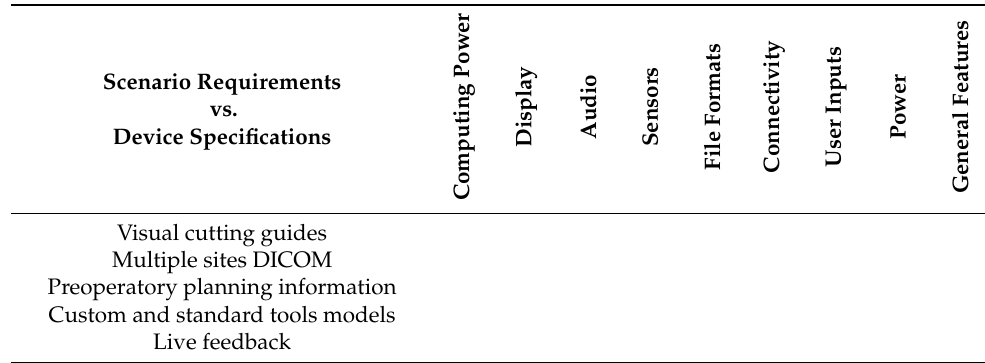
Table 6. QFD framework: requirements (rows) vs. specifications